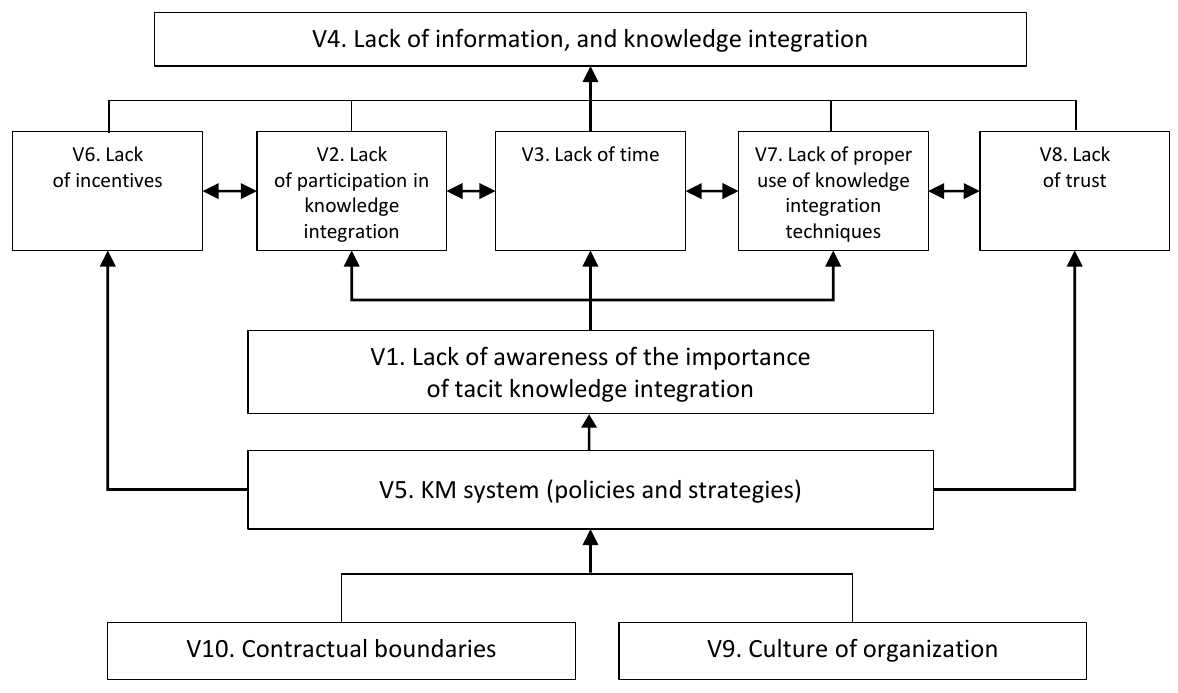
Figure 1. ISM-based model of KI challenges in the